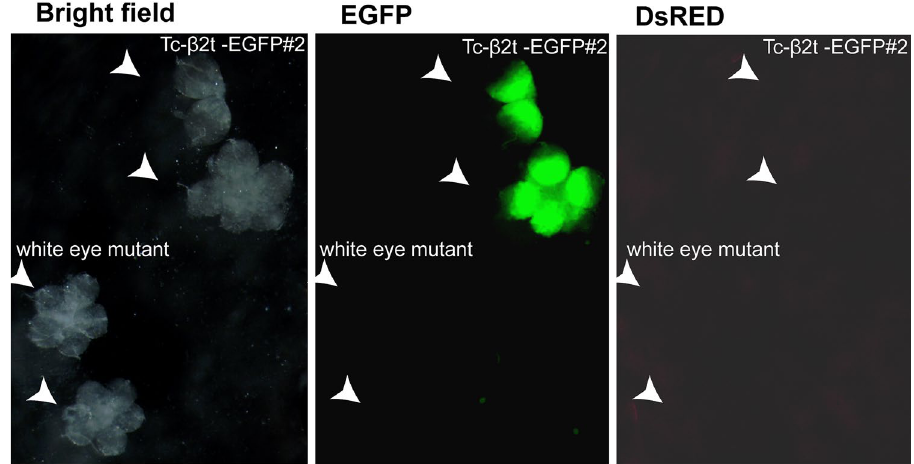
Figure 4. Tc-β 2 t cis -regulatory regions drive EGFP expression in testes. ( A ) Testes were dissected from Tc-β 2 t- EGFP#2 (top right) and white eye mutant (lower left) beetles and viewed under bright field, EGFP or DsRED filters.